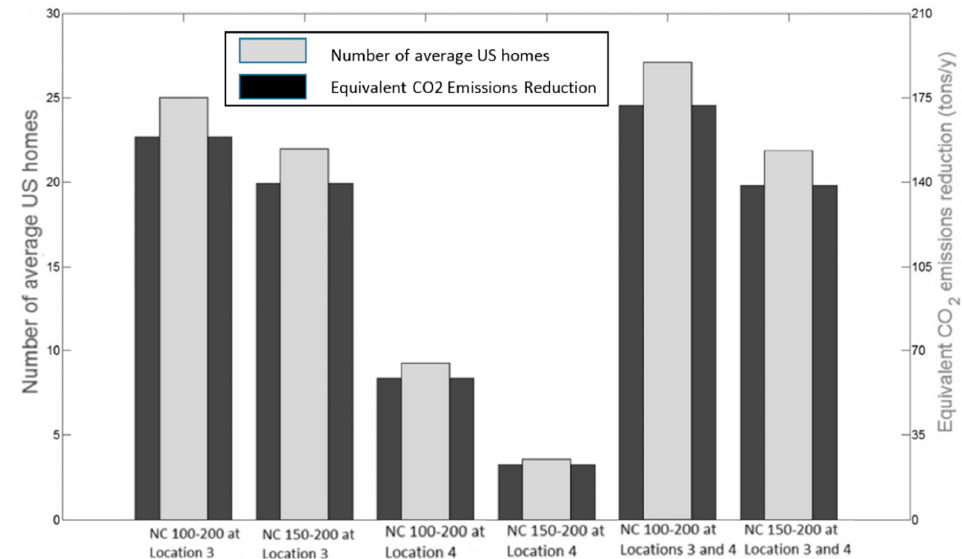
Figure 13. Economic and environmental impacts of the energy saving in the pump-driven network.